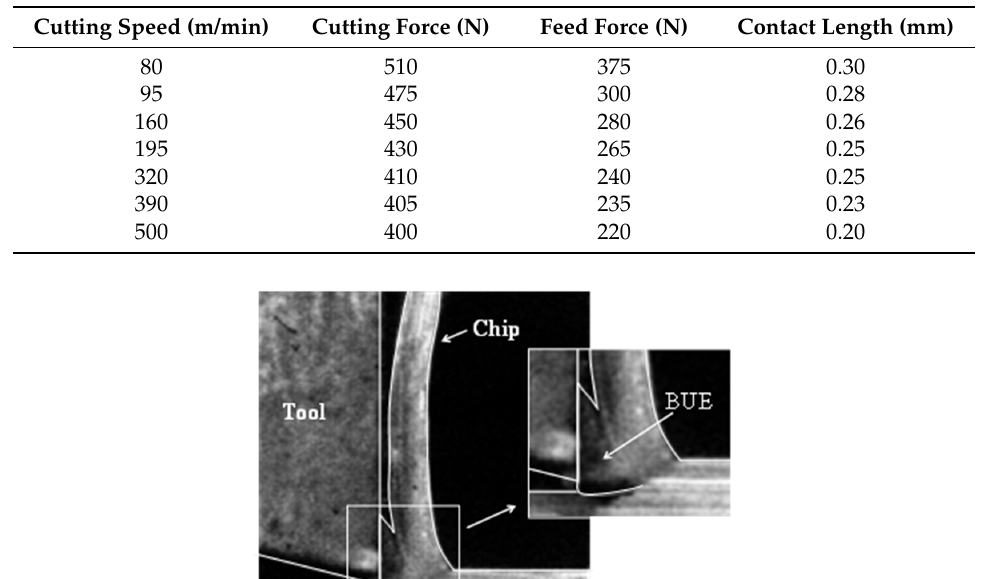
Table 2. Average cutting force, feed force and contact length for different cutting speeds [12].